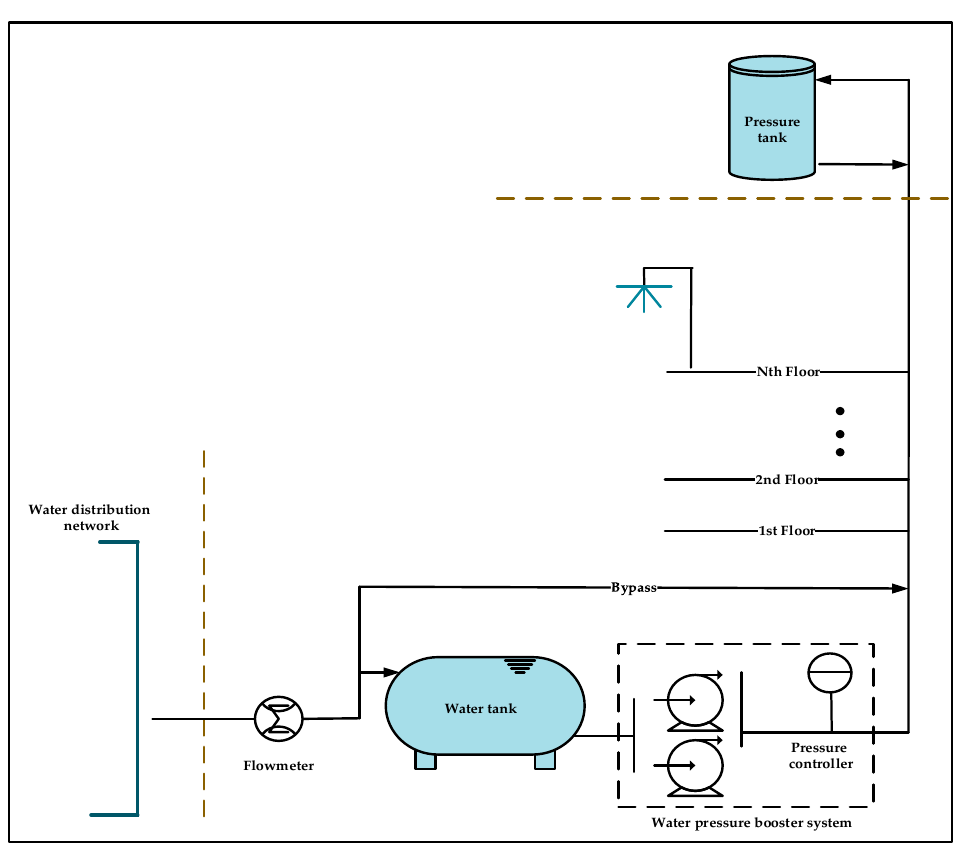
Figure 2. The domestic water supply system.